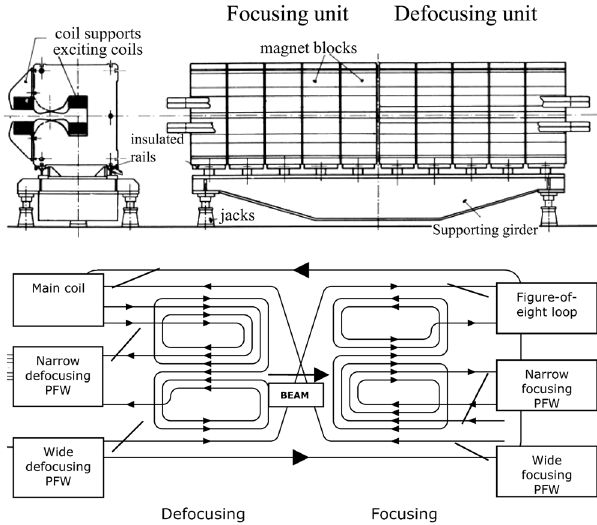
SPS.FIG. 6. Sketch of the PS main magnet (upper) and of the five circuits used to control tunes and chromaticities (lower), from Ref. [35]. The additional coils enable generating a transverse variation of the magnetic field, which is used to produce non- linear field components essential for the control of the transverse splitting.